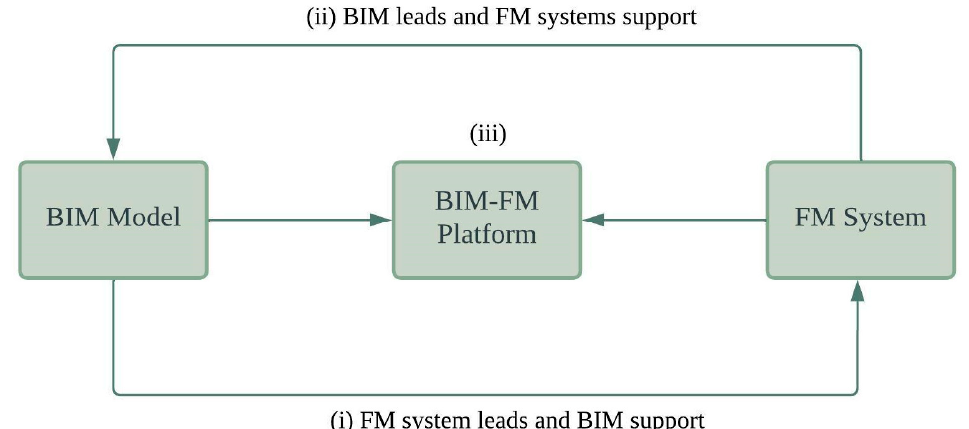
Figure 7. AI applied to FM categories conventional data integration approaches [163].